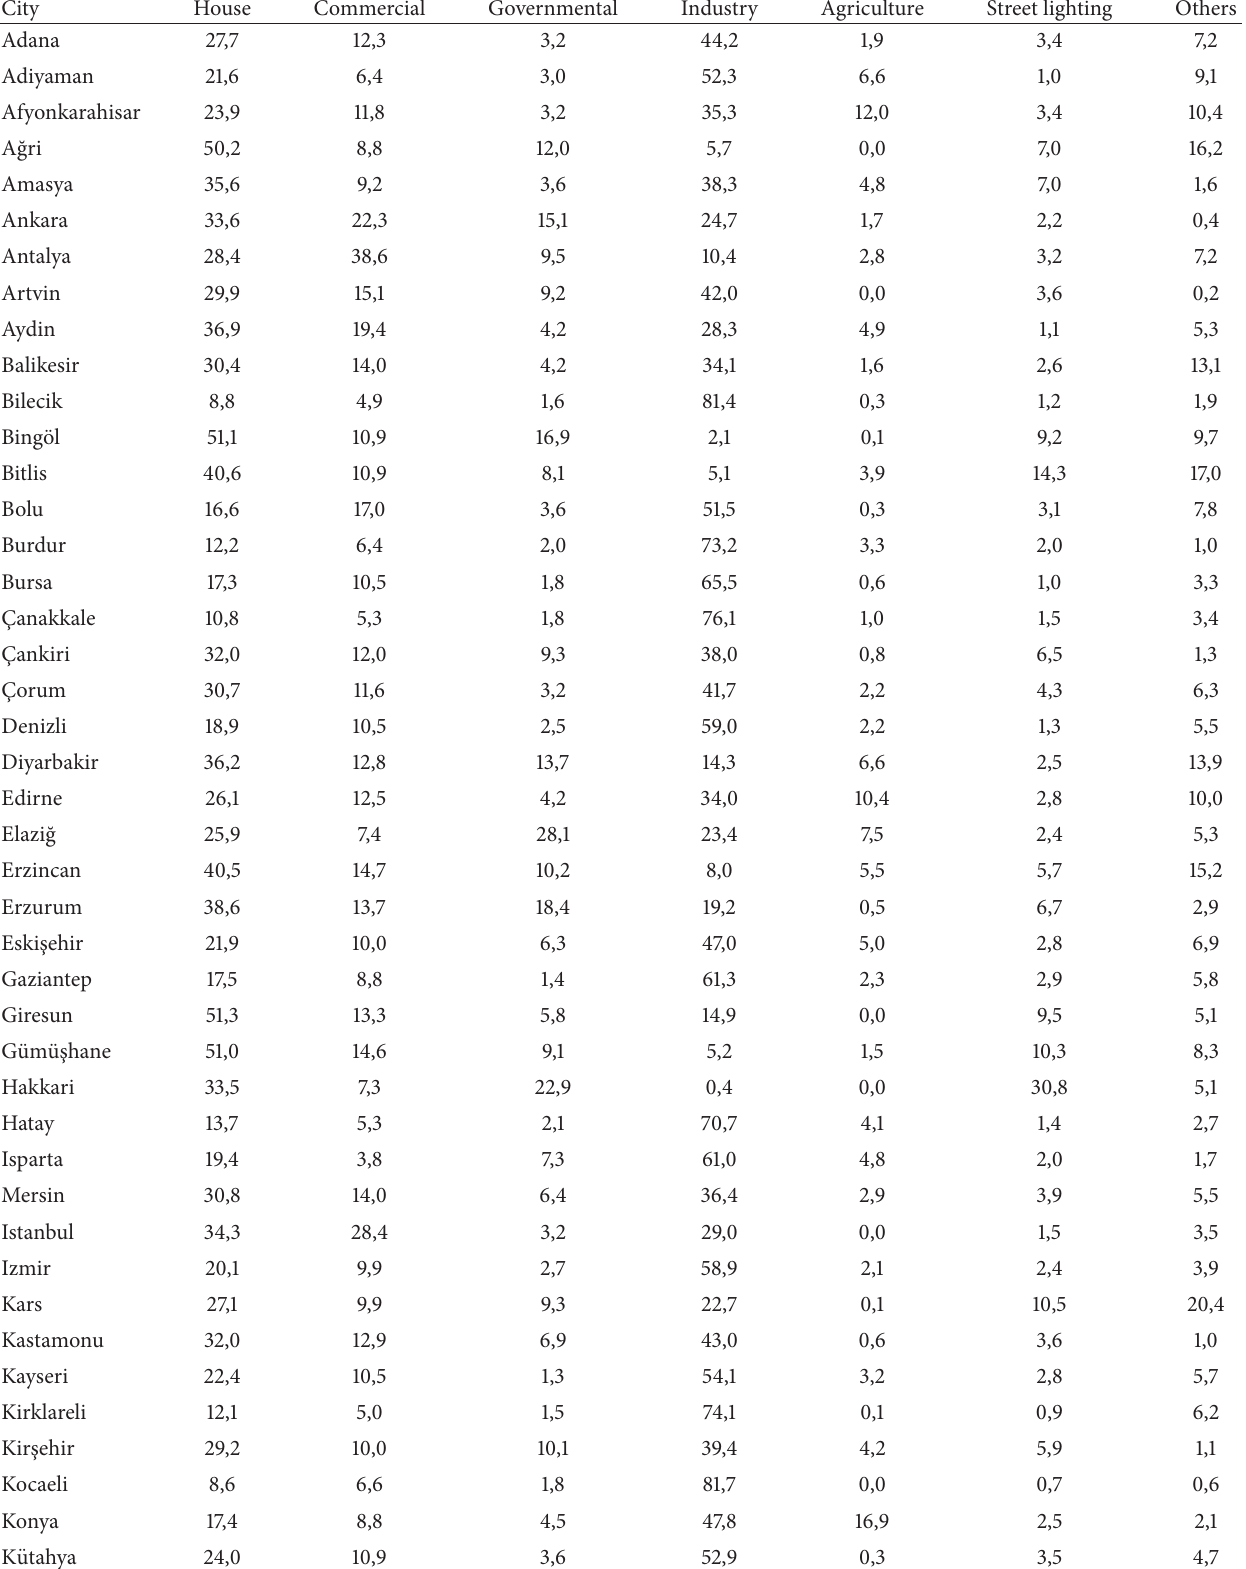
Table 2: Example data for electricity consumption in sectors for